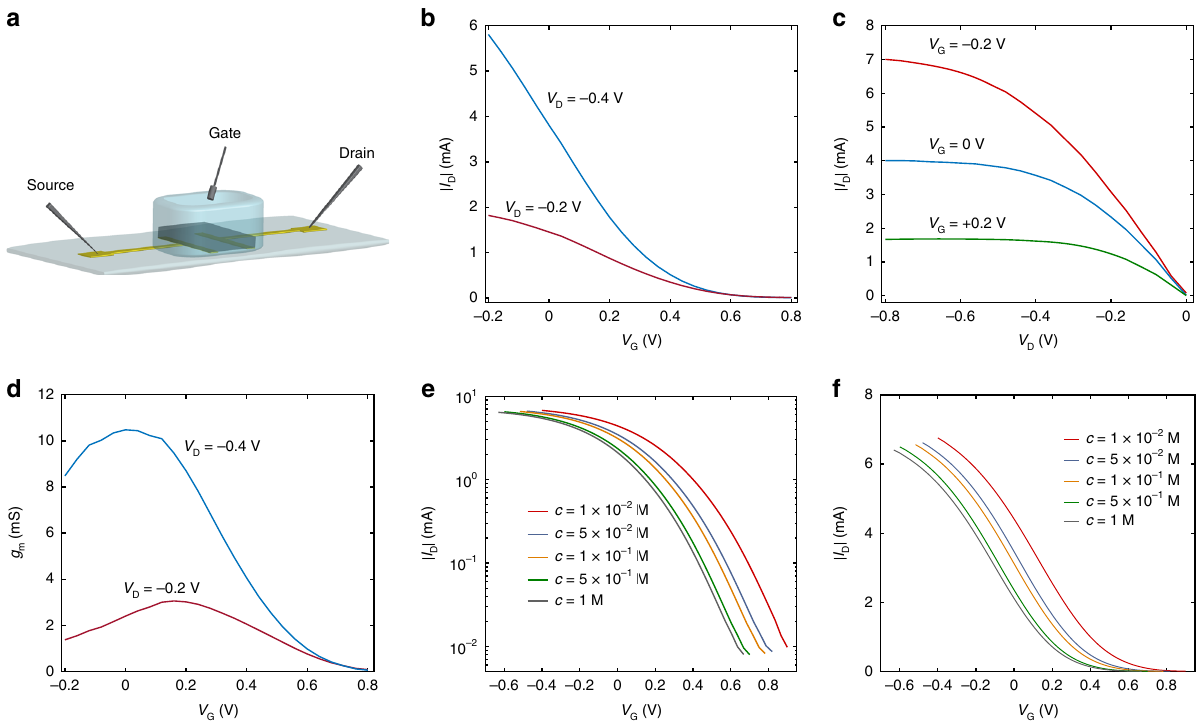
Fig. 1 OECTs structure and electrical characteristics. a Schematic representation of an OECT. b Typical transfer characteristics in linear scale of an OECT. c Typical output characteristics of an OECT. The NaCl concentration is 100 mM. d Measured transconductance g m = d I D /d V G , with a maximum g m of about 10mS at V G = 0 V and V D = − 0.4 V. The transconductance normalized to the device geometry and drain voltage amounts to 60 Scm − 1 V − 1 . e , f Typical transfer characteristics (semi-log scale and linear scale) measured at several NaCl concentrations and at V D = − 0.4V. The device thickness is